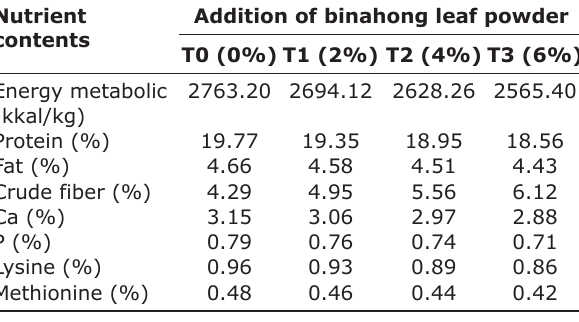
Table-2: Nutrition content of the